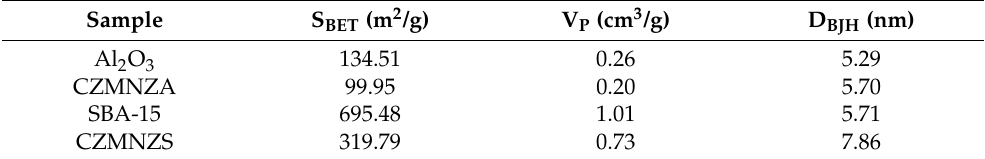
Table 1. Textural properties of Al 2 O 3 and SBA-15 bare supports and their impregnated